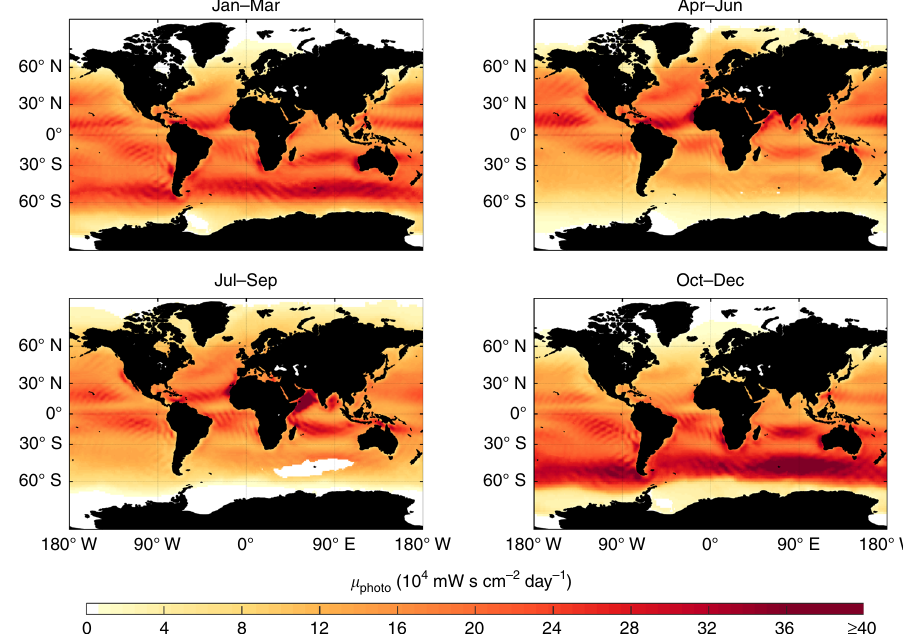
Fig. 2 Seasonal VOC emission potential from interfacial photochemistry of biogenic surfactants. The depicted estimations assume a sea surface microlayer wind speed limit of 13 m s – 1 (for wind speed limits of 8 and 10 m s – 1 , see Supplementary Figs. 1 and 2). Especially in remote marine regions with low microbiological activity, VOC formation from interfacial photochemistry is expected to play a signi fi cant